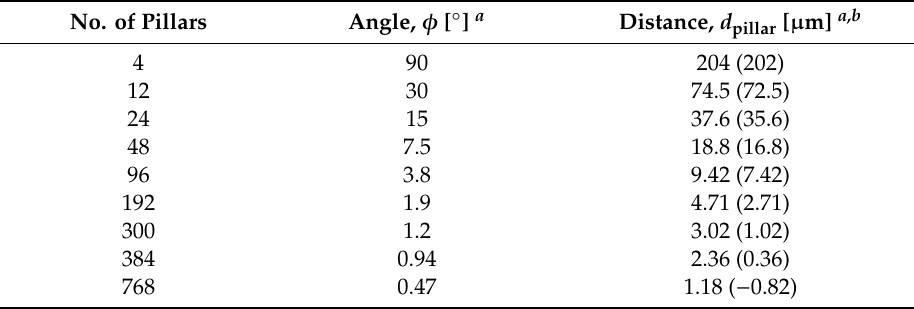
a φ and d b Values in parentheses are the shortest distance between the neighboring pillar are denoted in Figure 3a; pillars ( d pillar − 2 × r pillar